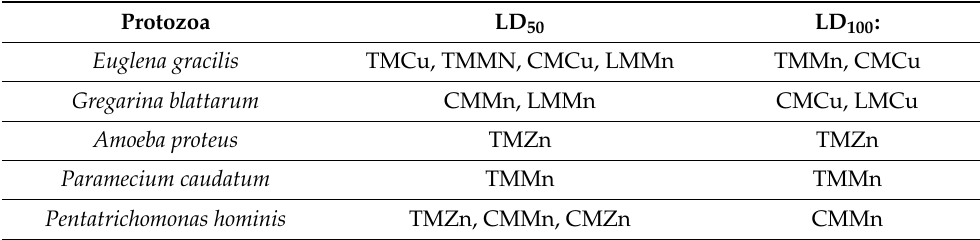
Pentatrichomonas hominis TMZn, CMMn, CMZn